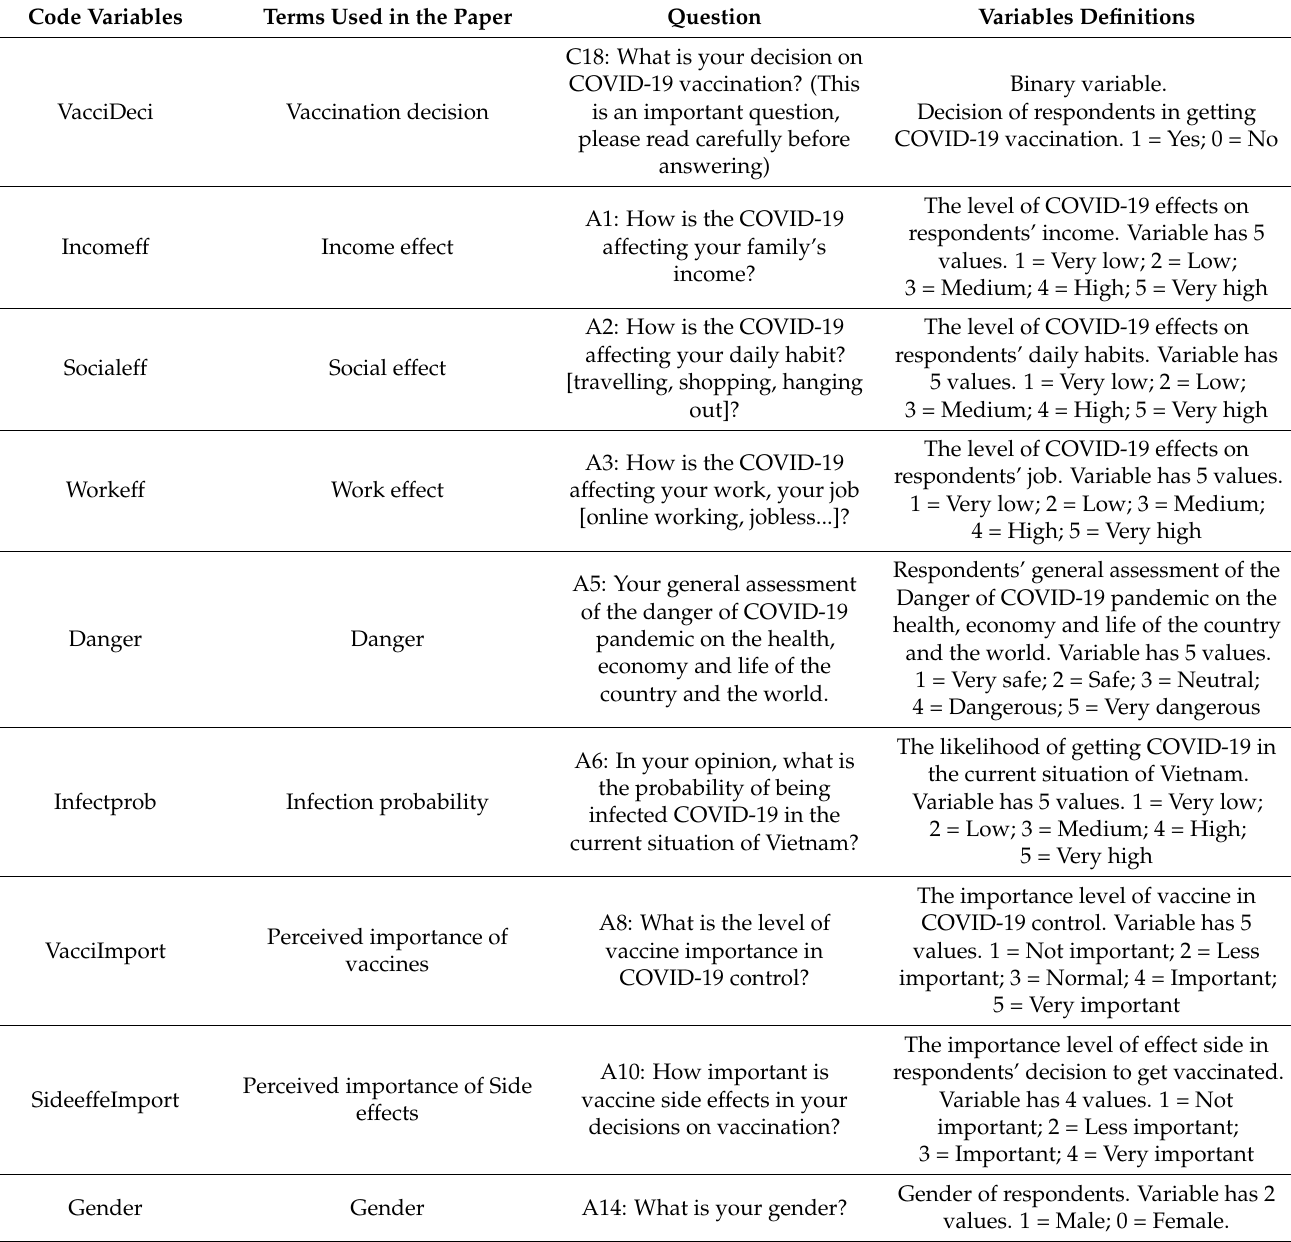
Table 2. Variables and